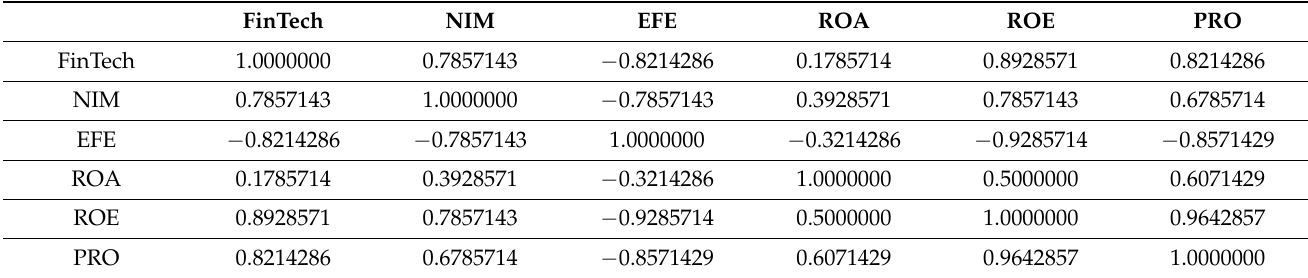
Table 9. Correlation matrix.